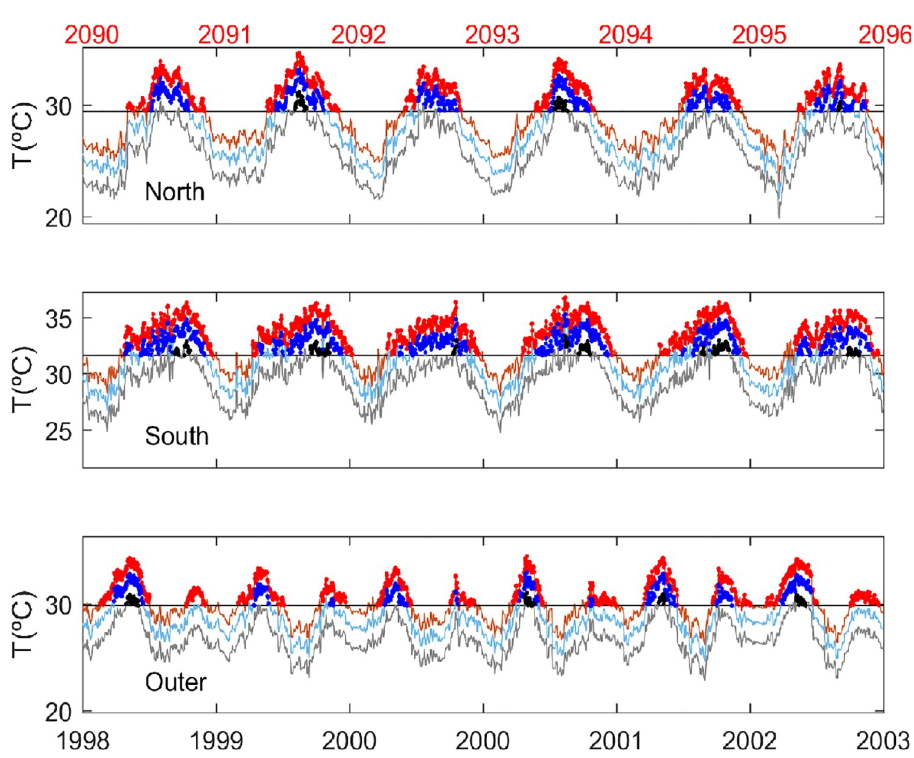
Fig 12. Daily SST averaged in the north (Top panel), south (middle panel) and Outer Region (bottom panel) for present conditions (grey), under scenario RCP 4.5 (light blue) and under scenario RCP8.5 (orange). The dots indicate the occurrence of MHWs in present conditions (black), under scenario RCP 4.5 (blue) and under scenario RCP 8.5 (red). For clarity only a limited period is plotted (1998–2003 for the present conditions, bottom axis and 2090–2096 for the future conditions, top